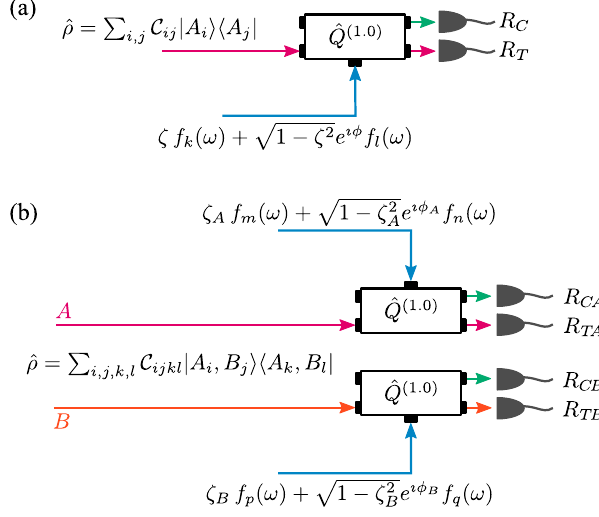
FIG. 7. (a) TM state tomography of a single-photon state with density matrix ˆ ρ . Both transmitted and converted output of the QPG are detected with single-photon detectors. (b) Generalized scheme for the TM tomography of a biphoton state. Photons “ 1 ” and “ 2 ” are sent to two different QPGs, and the transmitted and converted outputs are detected with single-photon